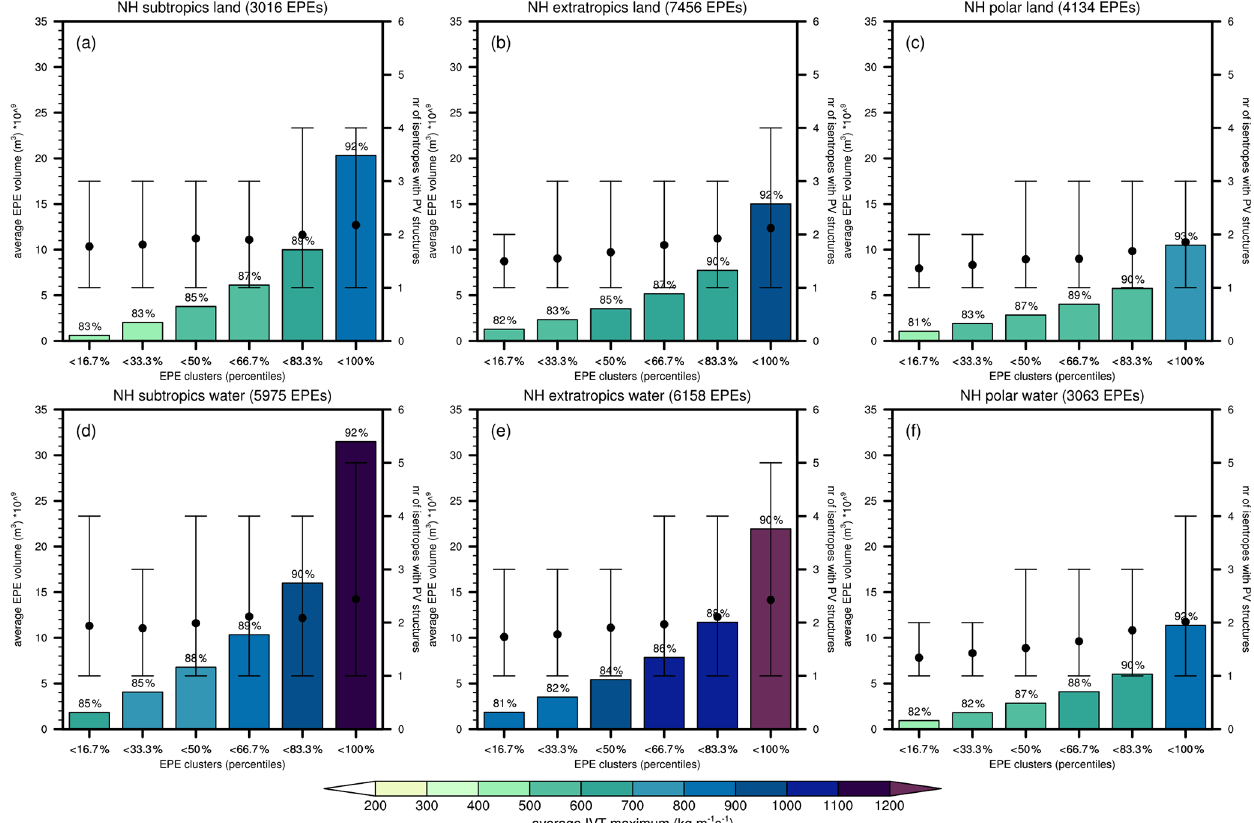
Figure 8. Characteristics of PV and IVT structures for EPEs, linked to combined wave breaking and intense moisture transport, divided and ranked in six clusters based on their precipitation volumes for the northern hemispheric (a, d) subtropical (20–40 ◦ N), (b, e) extratropical (40–60 ◦ N), and (c, f) polar (60–80 ◦ N) regions, over (a, b, c) land and (d, e, f) water. The number of isentropes with PV structures is shown by the 10th to 90th percentile range and the average indicated by the dot, and the average of the IVT maxima (kgm − 1 s − 1 ) is shown by the colours of the bars. The height of the bars corresponds to the average precipitation volumes (m 3 ) of each EPE cluster. The number of EPEs for each region is included in the figure titles, and the numbers above the colour bars indicate the fractions (%) of 6-hourly time instances with combined PV and IVT structures during the daily